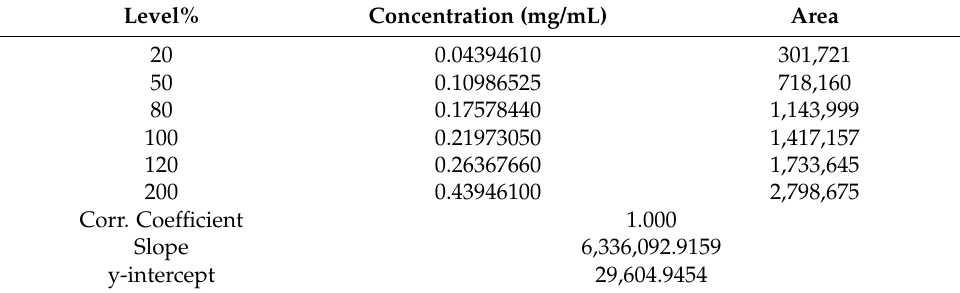
Table 5. Results of System Suitability.